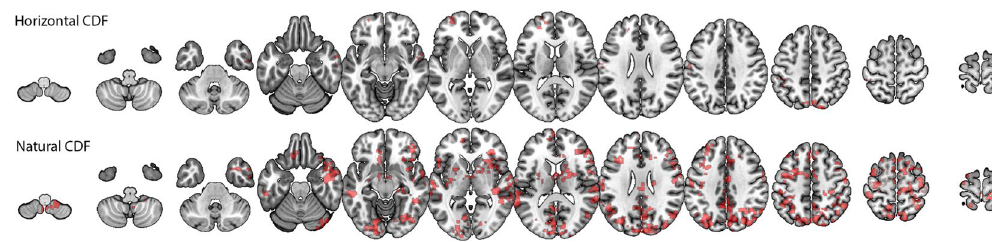
Figure 6. Brain areas where spontaneous activity patterns differed between wakefulness and N2 sleep. In these areas, the difference between top and bottom graphs varied systematically between wakefulness and sleep. Images were generated using Neuroimaging FSL